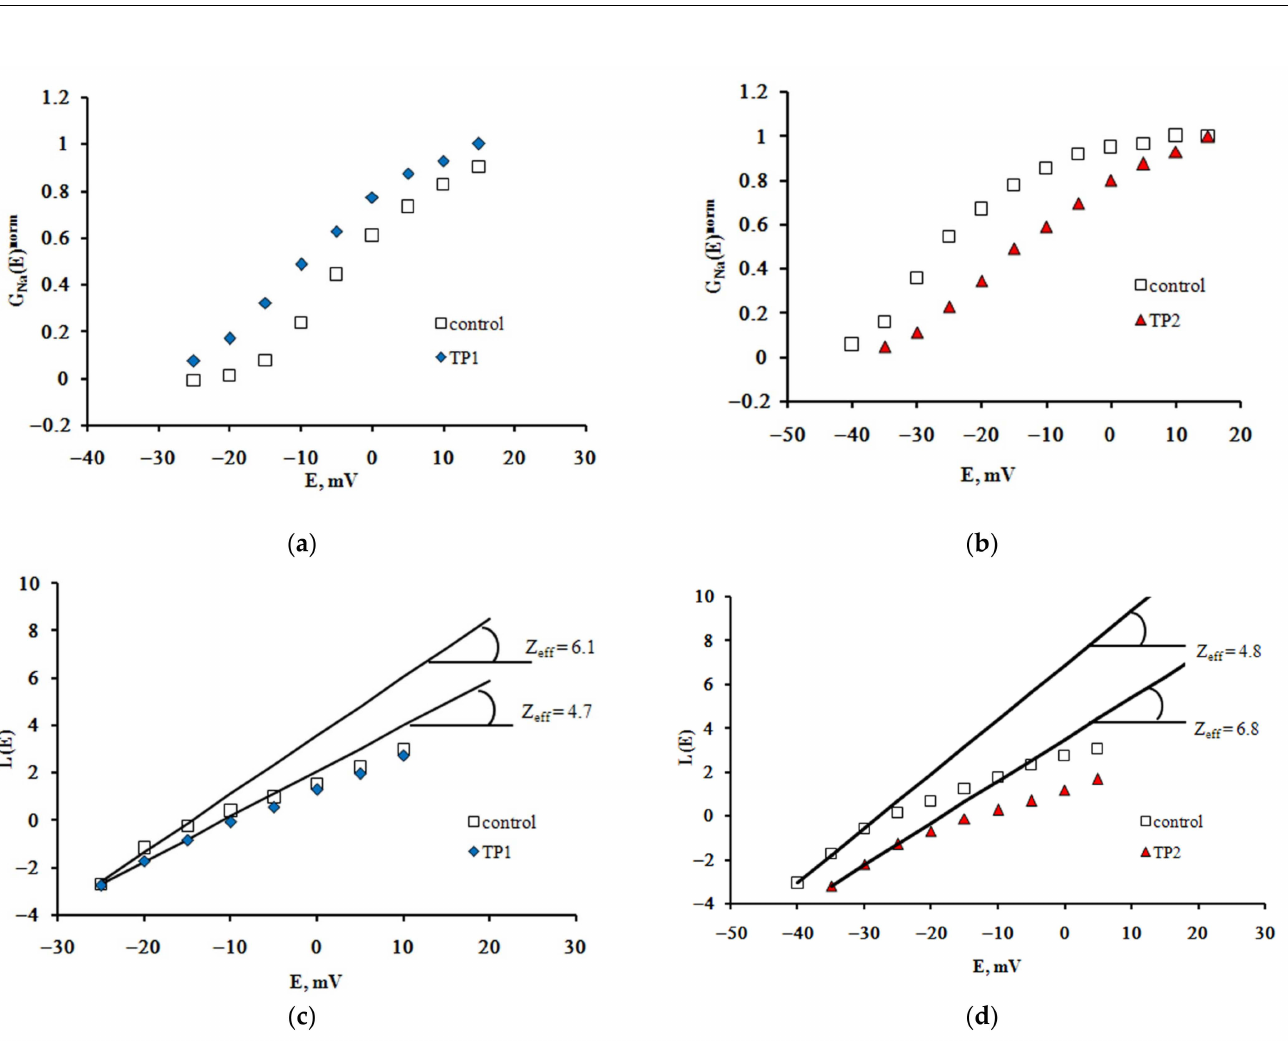
Figure 2. TP1 and TP2 modulate voltage sensitivity of the Na V 1.8 channel activation gating device. Voltage dependence of the Na V 1.8 channel chord conductance in the control experiment and after application of TP1 ( a ) and TP2 ( b ). The function G Na (E) was normalized, i.e., we plotted G Na (E) norm = G Na (E)/G Namax (E), where G Namax (E) is the maximal value of G Na (E). Z eff was evaluated from the tangents of the slopes of the asymptotes passing through the very first points of the L(E) function. Z eff decreased significantly after application of TP1 ( c ) and TP2 ( d